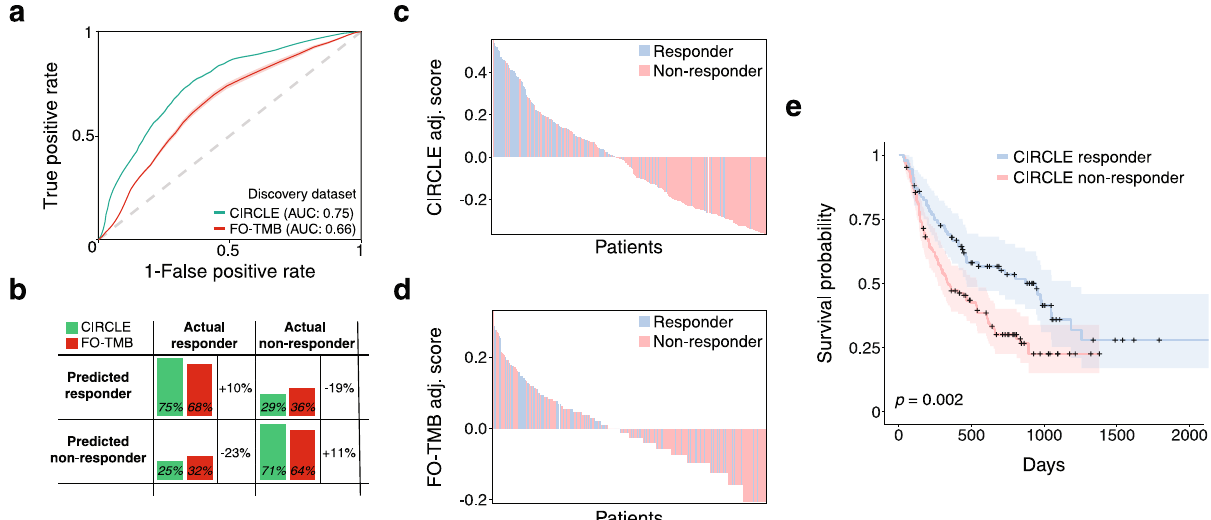
Fig. 5 The cancer immunotherapy response CLassi fi Er (CIRCLE) predicts ICB response and patient survival. a Averaged areas under the receiver- operator curve (AUCs) from 100 Monte Carlo cross validation iterations of the CIRCLE classi fi er and the FoundationOne CDx tumor mutational burden (FO-TMB) classi fi er. Error shading indicates the standard deviation of AUCs calculated from the 100 cross validation iterations. b Absolute values and percent change in the true positive rate (sensitivity), true negative rate (speci fi city), false positive rate and false negative rate of the CIRCLE classi fi er and FO-TMB classi fi er. c – d Waterfall plots of per patient scores from the CIRCLE ( c ) and FO-TMB ( d) classi fi ers. Each patient is represented as a vertical bar and the adjusted score is equal to the score of the indicated classi fi er minus the optimal cutoff derived from the respective receiver operating characteristic curves. e Kaplan – Meier plot of overall survival for patients classi fi ed as CIRCLE responders versus CIRCLE non-responders. Shaded areas indicate the 95% con fi dence interval. Statistical signi fi cance was calculated using a two-sided Cox proportional hazards test with tumor type as a